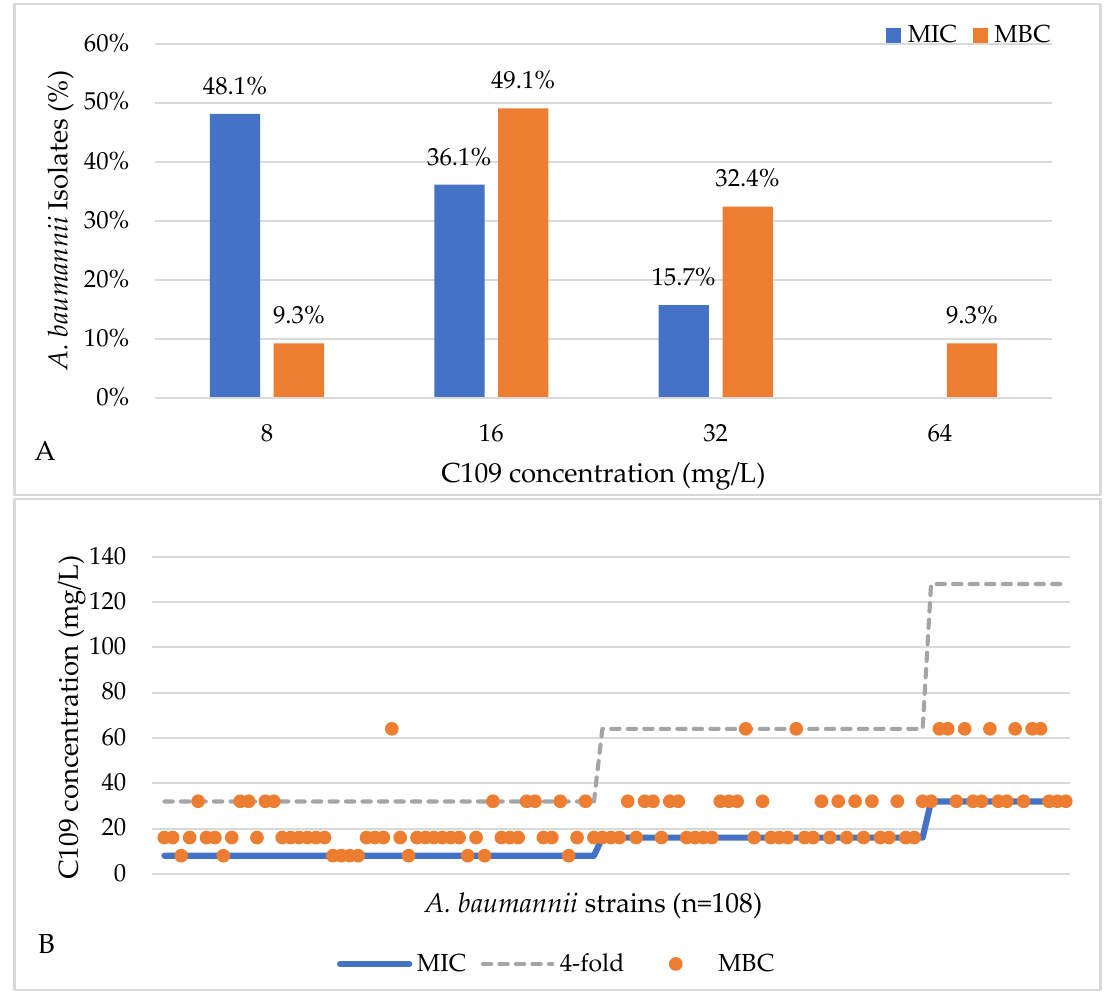
Figure 2. ( A ) MIC and MBC values of C109 obtained for A. baumannii strains (n = 108). ( B ) the bactericidal effect of C109 on A. baumannii isolates (n = 107/108).